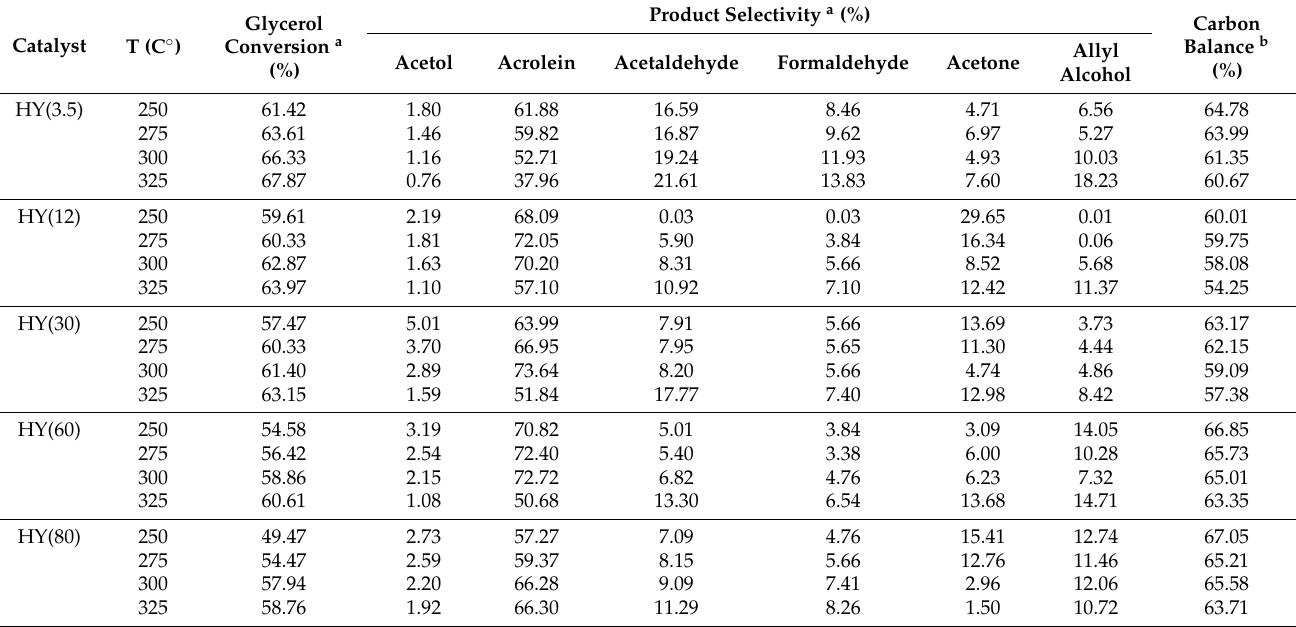
Table 2. Initial glycerol conversions and product selectivities of the HY zeolites at different temperatures.